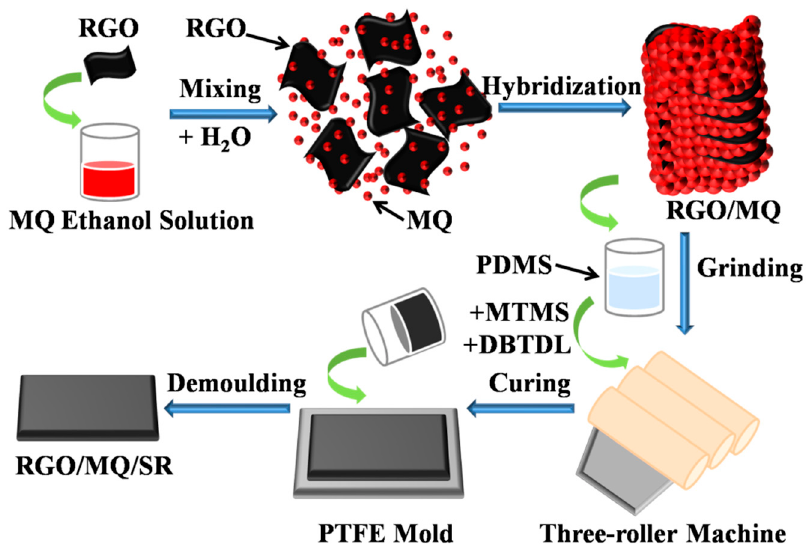
Figure 1. Scheme for the preparation of RGO/MQ/SR composites.